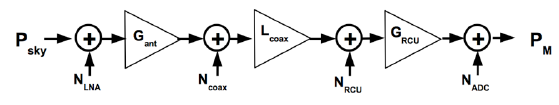
Figure 1. LOFAR signal chain, following sky power, P sk y to recorded power, P M . Gains, losses, and electronic noise additions are